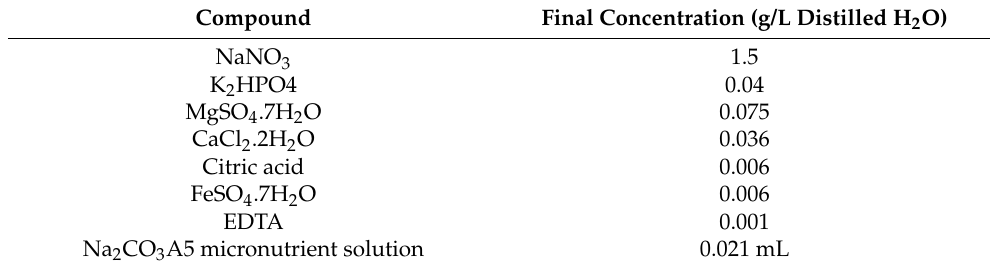
Table 1. BG 11 culture media used in cultivating C. reinhardtii.